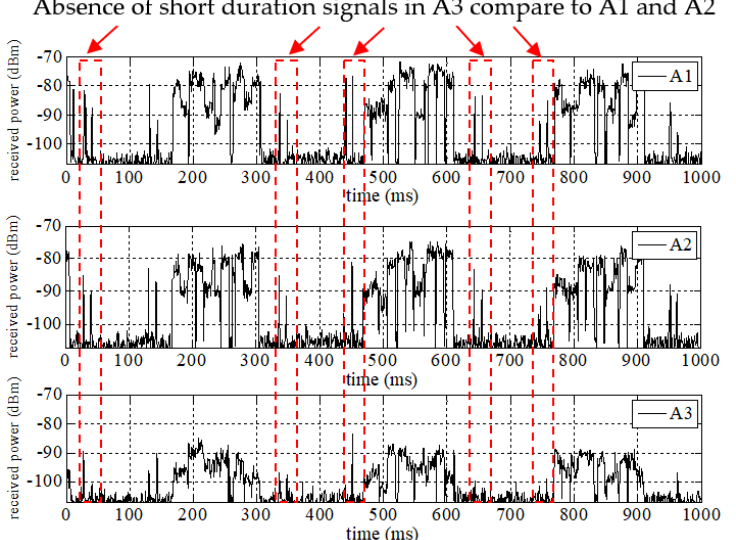
Figure 10. Effect of directional antenna on received power and short duration packets in channel ‘1’.